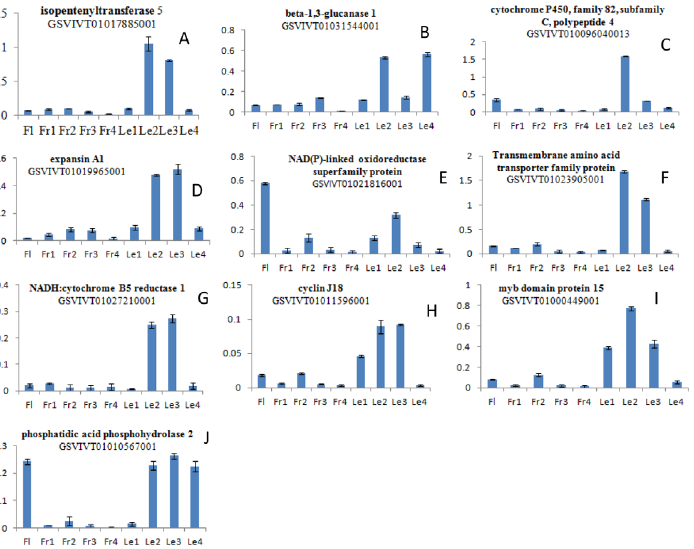
Fig 4. Quantitative RT-PCR validation of differential expressed transcripts observed for 10 selected genes, measured by RNA-Seq and qRT-PCR. (Fl; Flower, Fr; Fruit, Le;